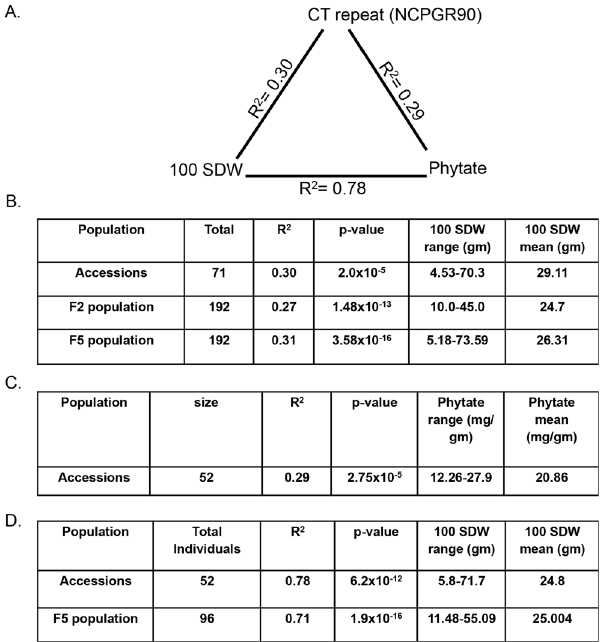
Figure 1. Association analysis of NCPGR90 with seed weight and phytate: Three-way association analysis of NCPGR90, 100 SDW and phytate content with each other. Association coefficients (R) are mentioned for each pair ( A ). Tables showing data of association analysis of NCPGR90 with 100 SDW in 71 chickpea germplasm accessions, F 2 mapping population (ICCX-810800 × ICCV95334) and F 5 mapping population (ICCV95334 × ICCX-810800) ( B ) association analysis of 100 SDW with seed phytate content (mg PA/ gm dry weight) in 52 chickpea germplasm accessions and 96 individuals of F 5 mapping population (ICCV95334 × ICCX-810800) ( C ) and association analysis of NCPGR90 with seed phytate content in 52 chickpea germplasm accessions ( D